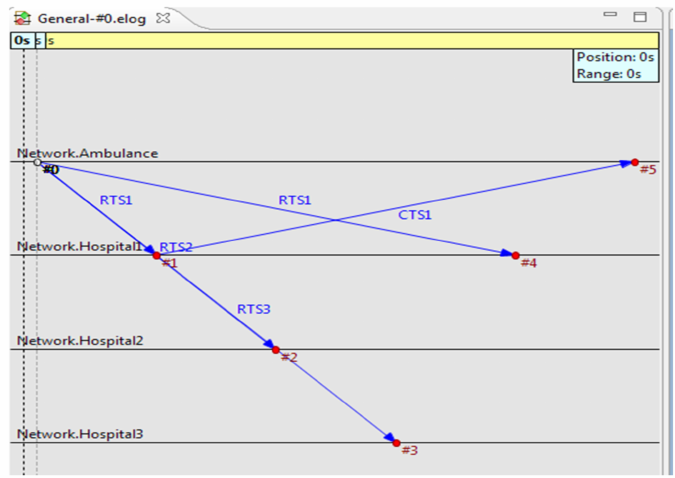
Figure 14. Signal diagram under the OMNeT++